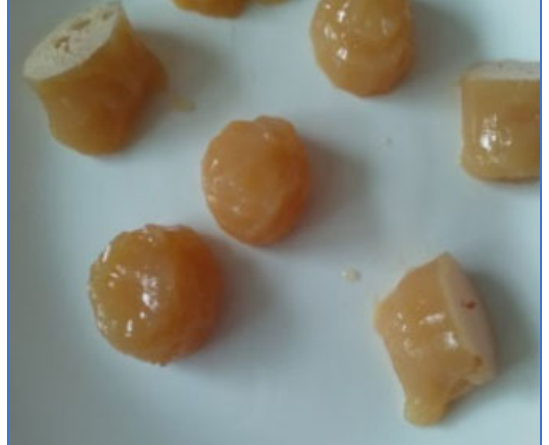
Figure 6. Jellies made with sericin as an ingredient. Reproduced from Matran et al. [67] distributed under the terms and conditions of the Creative Commons Attribution License (CC BY) by MDPI, 2022, Licensee MDPI, Basel, Switzerland (originally Figure 1).